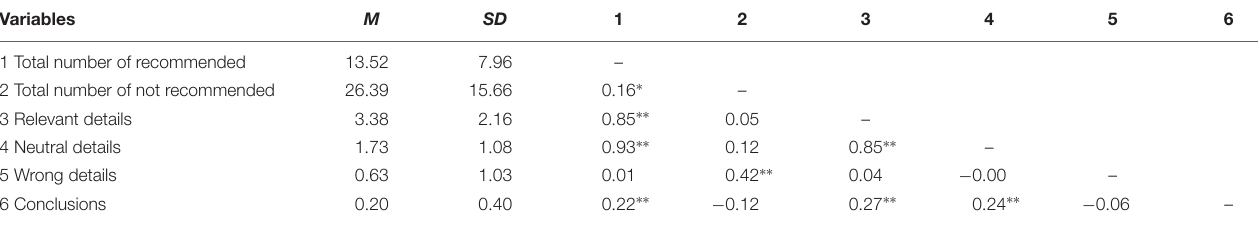
TABLE 2 | Means, standard deviations, and correlations among questions type details and